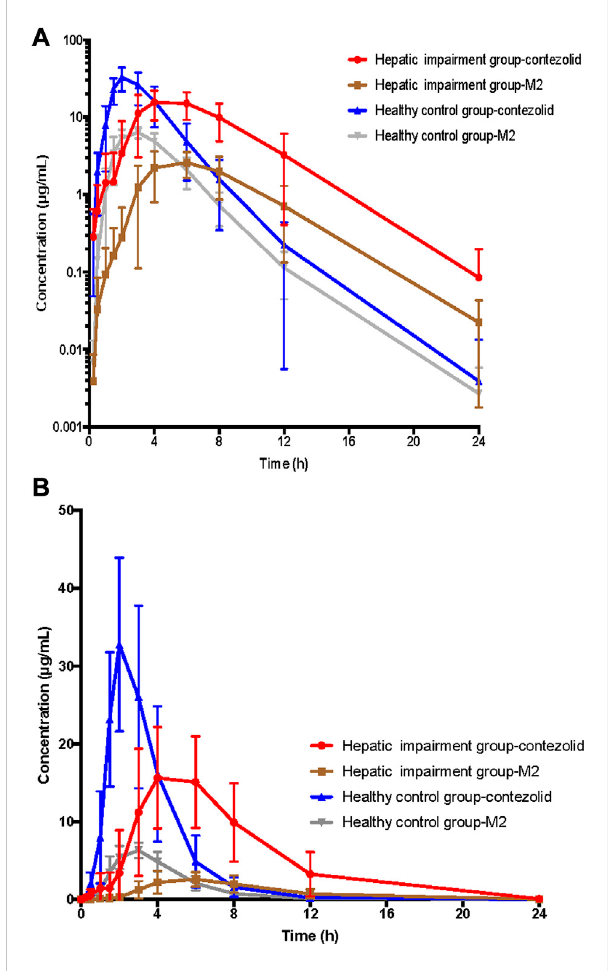
FIGURE 1 Mean (±SD) contezolid and M2 plasma concentration-time pro fi les following a single oral dose of contezolid 800 mg in the patients with moderate hepatic impairment and healthy controls with normal liver function. (A) The semi-logarithmic scale. (B) The linear scale. SD, standard deviation.